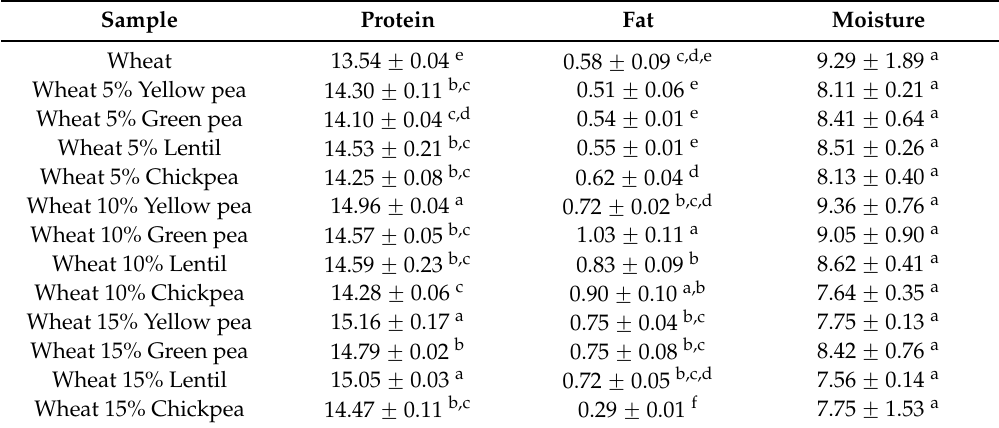
Table 3. Proximate compositions of the wheat based extrudates (measured as g/100 g dry matter